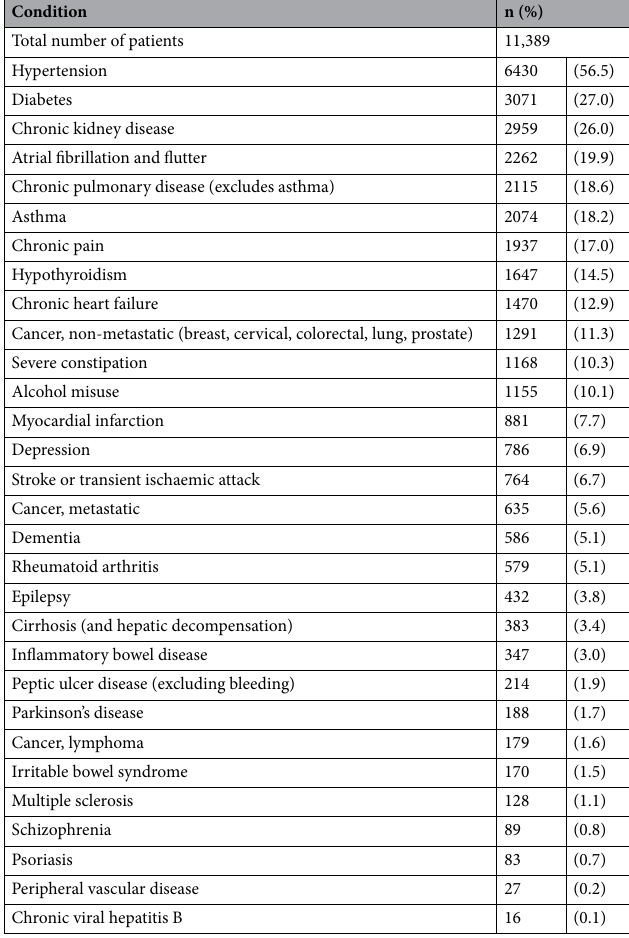
Table 2. Prevalence of individual conditions among patients with